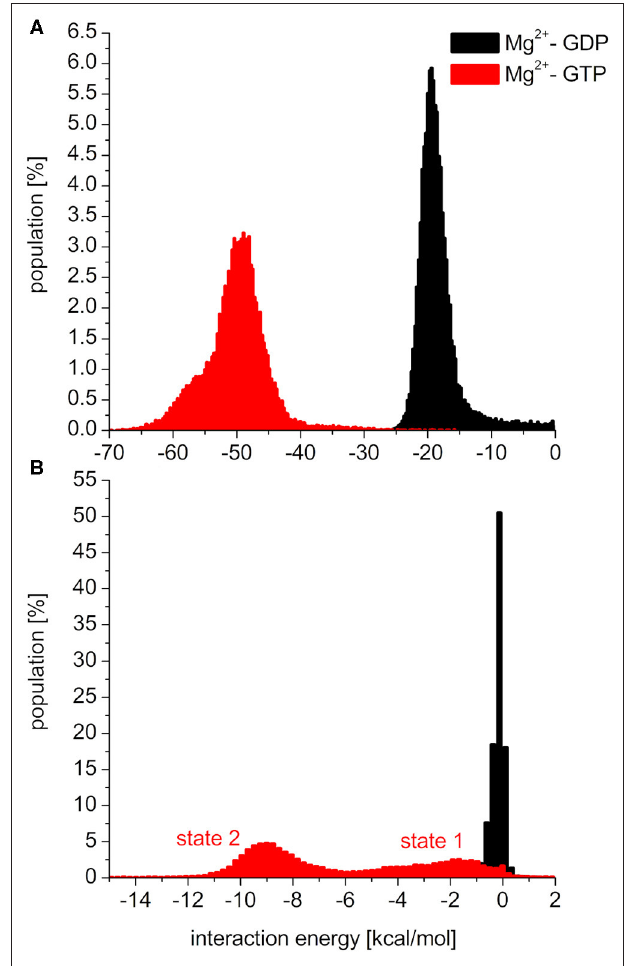
FIGURE 5 | Distributions of interaction energies between the nucleotide (Mg 2 + -GDP: black, Mg 2 + -GTP: red) and (A) : switch1 region, (B) : switch2 region of